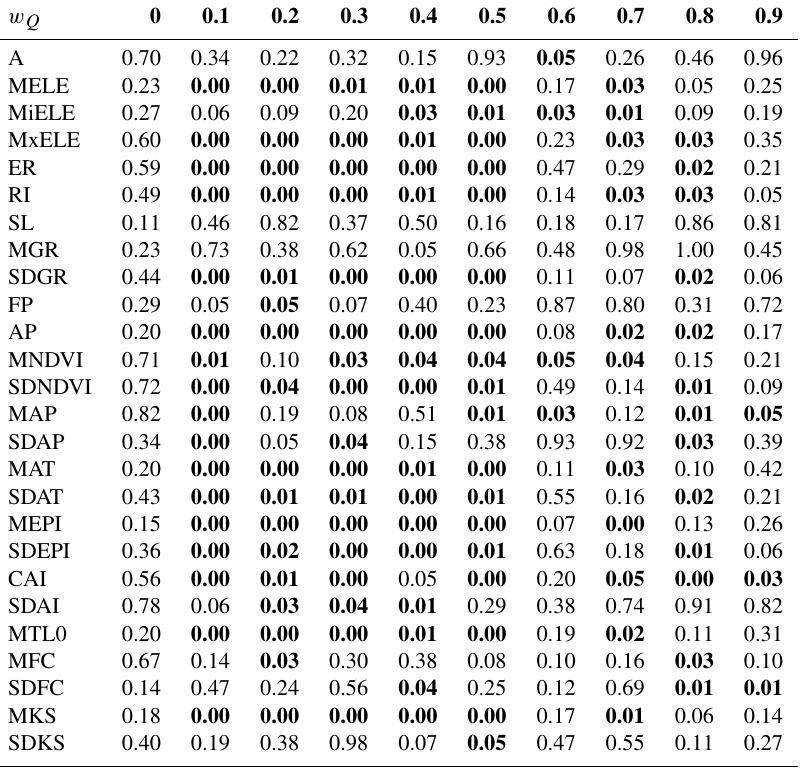
Table 6. Kolmogorov–Smirnov p values testing the similarity of the distribution of catchment attributes across the 213 catchments between those catchments where the runoff model efficiency is improved in the validation period by the inclusion of the soil moisture and snow data in the calibration and those catchments where this is not the case. The null hypothesis that the two samples were drawn from the same distribution is rejected if the p value is less than the significance level (shown in